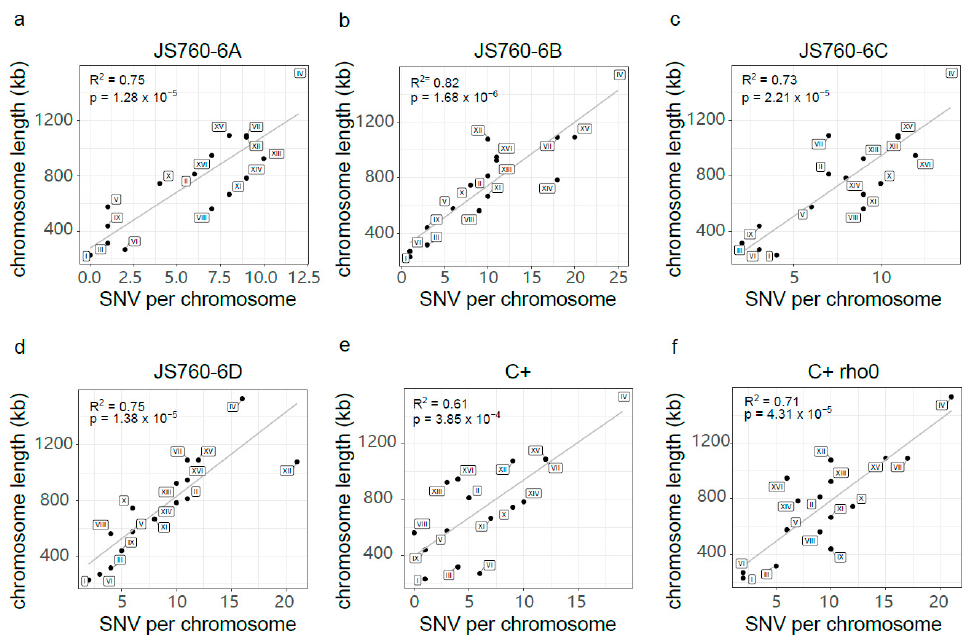
Figure 4. The number of SNVs positively correlates with chromosome lengths. The panels ( a – f ) show strong linear correlation between the number of SNVs identified on each chromosome for each strain ( x ‐ axis) and chromosome length ( y ‐ axis). The genotypes of the six strains are as below: JS760 ‐ 6A ( MRPL25 + atp3 G348T ), JS760 ‐ 6B ( mrpl25 Δ ATP3 + ), JS760 ‐ 6C ( MRPL25 + ATP3 + ), JS760 ‐ 6D ( mrpl25 Δ atp3 G348T ), C+ (positive control), C+ rho0 (negative control).